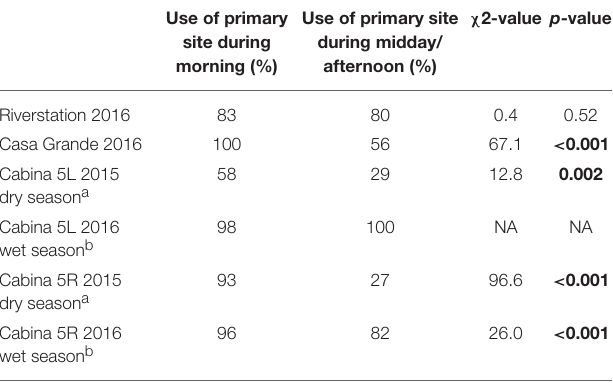
TABLE 2 | Results of chi-square tests on site-use patterns between morning and